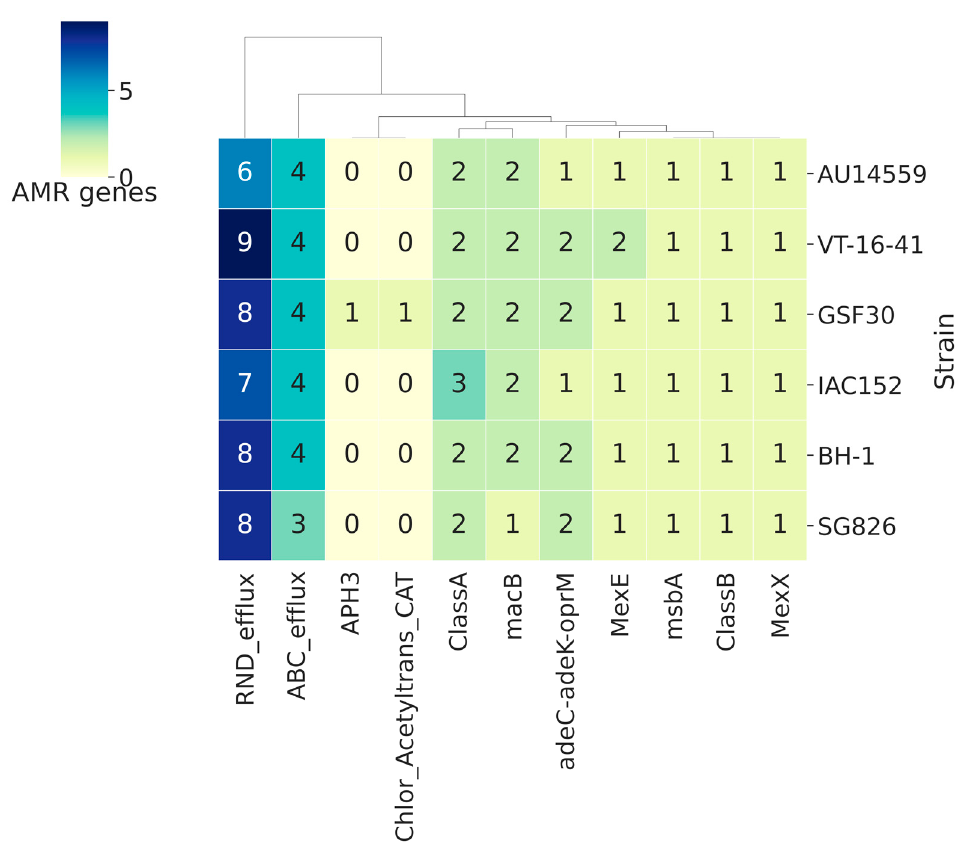
Figure 6. Clustermaps of the antibiotic resistance genes found in H. frisingense genomes. A repre- sentative of each cluster generated by Panaroo was compared with the ResFams database using the HMM ResFams core model. The lines in the clustermap represent the strains, and the numbers in the squares indicate the number of genes in that column found in the strain.